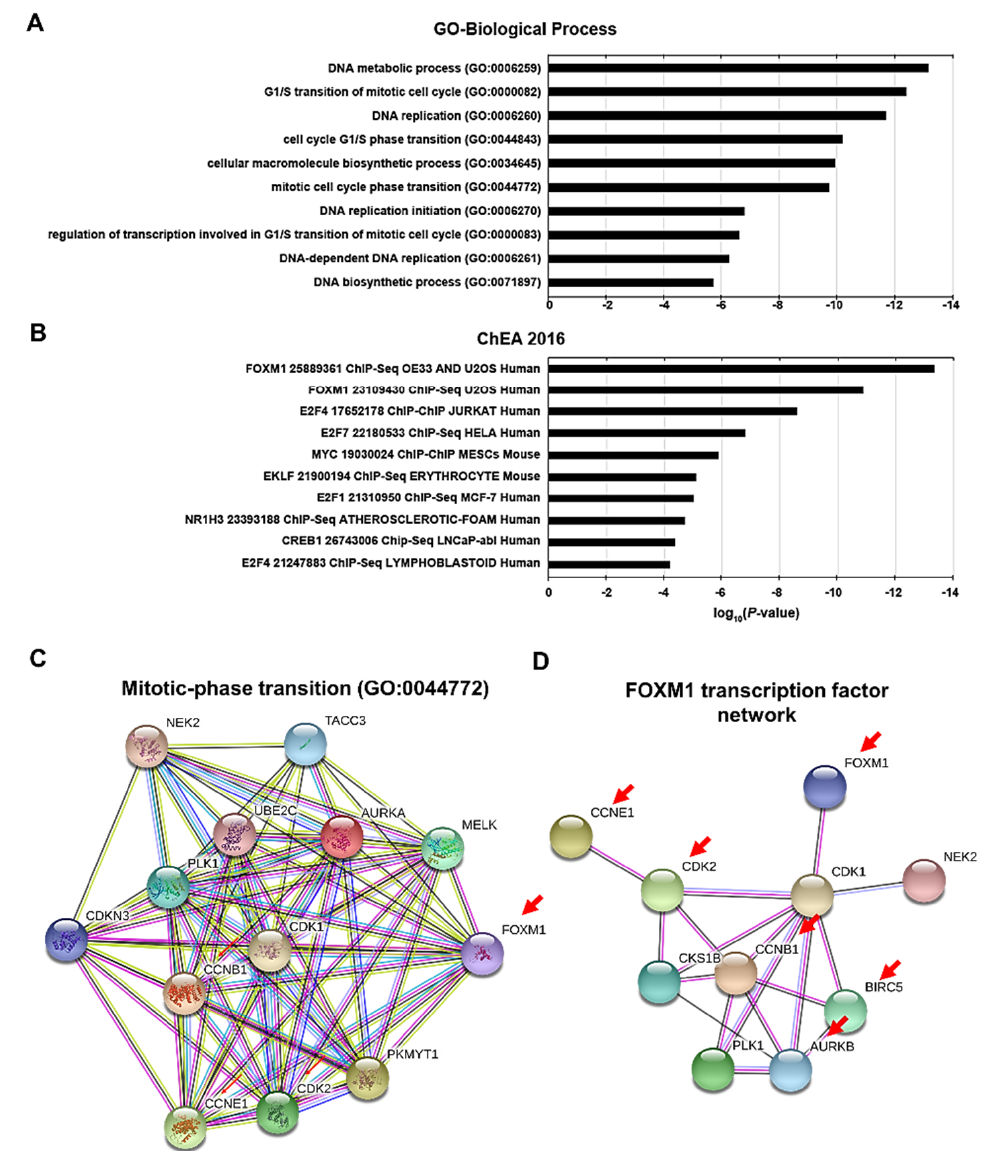
Figure 2. Altered transcription profiling and signaling pathways induced by FAM188B knockdown ( A , B ) A549 cells were transfected either with NC siRNA or siFAM188B for 48 h, followed by mRNA purification and RNAseq analysis. Downregulated genes by siFAM188B from RNAseq data were subjected to gene set enrichment analyses for gene ontology (GO)-biological process ( A ) and ChIP-X Enrichment Analysis (ChEA 2016) gene sets ( B ). Predictions of protein–protein interactions of downregulated genes categorized into forkhead box M1 (FOXM1) transcription factor network ( C ) and mitotic-phase transition by String-DB database ( D ).